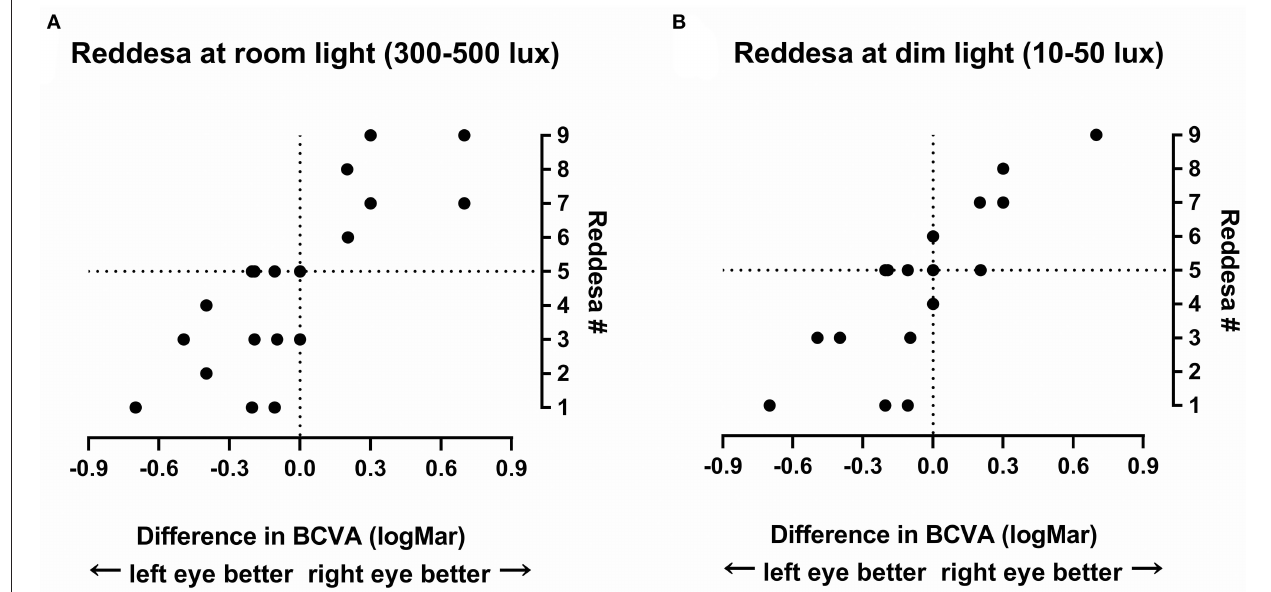
FIGURE 2 | The result of the Reddesa test of each patient ( N = 20) plotted against the difference of best-corrected visual acuity (BCVA; logMar) of the right and the left eyes in patients with unilateral optic neuritis at room light (A) and at dim light (B)